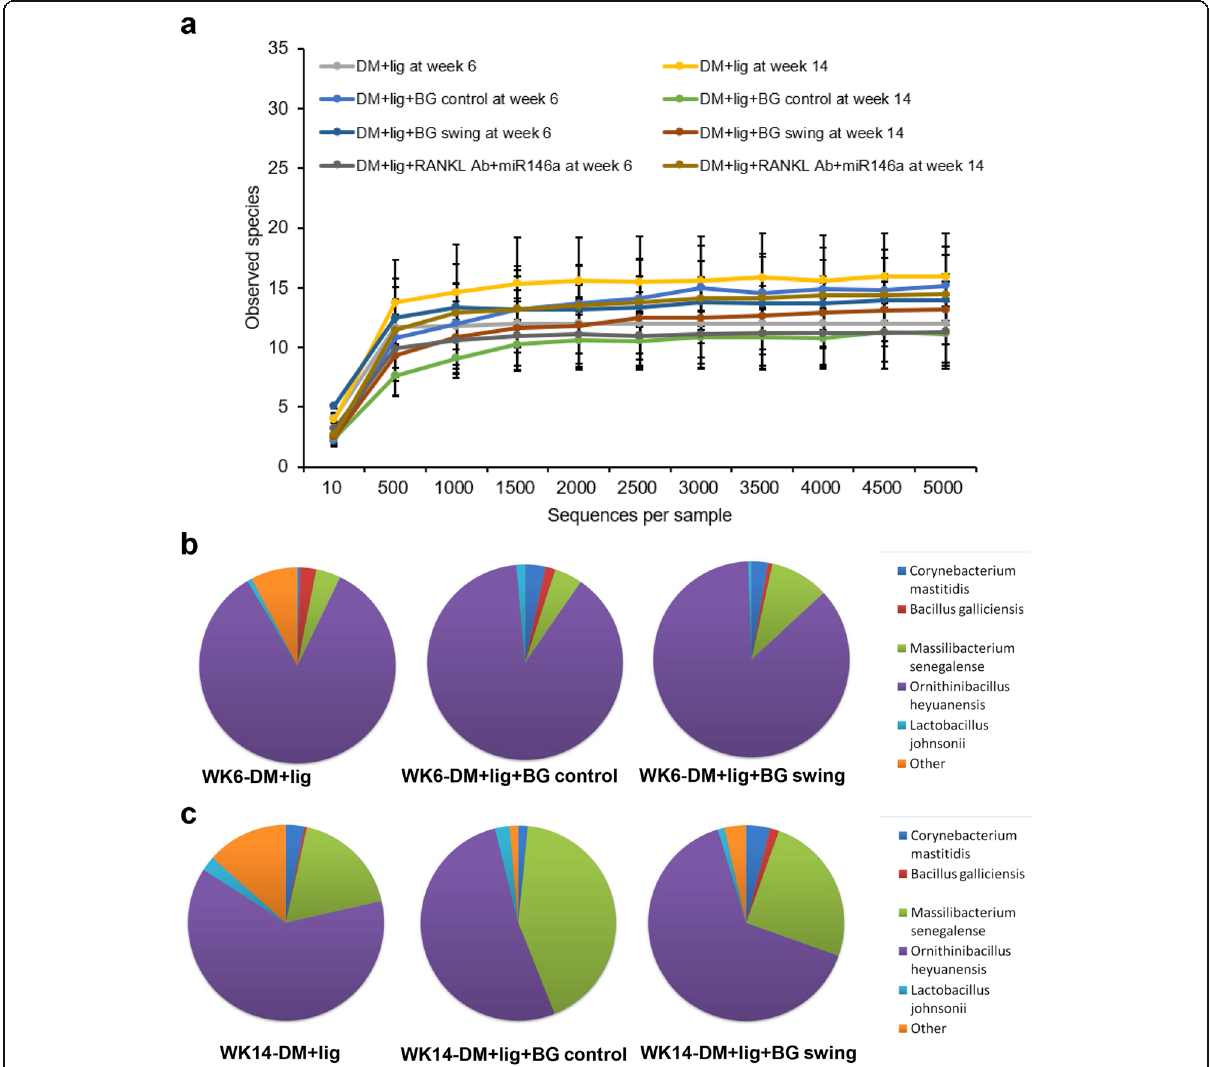
Fig. 6 Species of saliva oral bacteria were analyzed using 16S rRNA gene sequence. a Total numbers of observed species of oral bacteria from different groups at all timepoints (mean ± SD, n = 3). b Distribution of observed species of oral bacteria at WK6 (week 6), saliva samples from oral cavity were collected before implant insertion and glycemic alteration. c Distribution of observed species of oral bacteria at WK14 (week 14), saliva samples from oral cavity were collected before